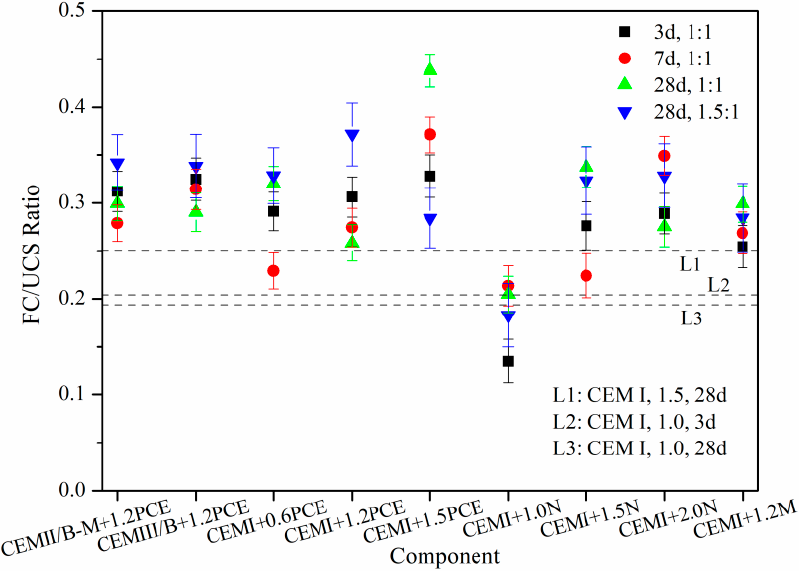
Figure 15. FS/USC ratio of SMCG with key formulation (cement type, SP type, SP content and W/S).